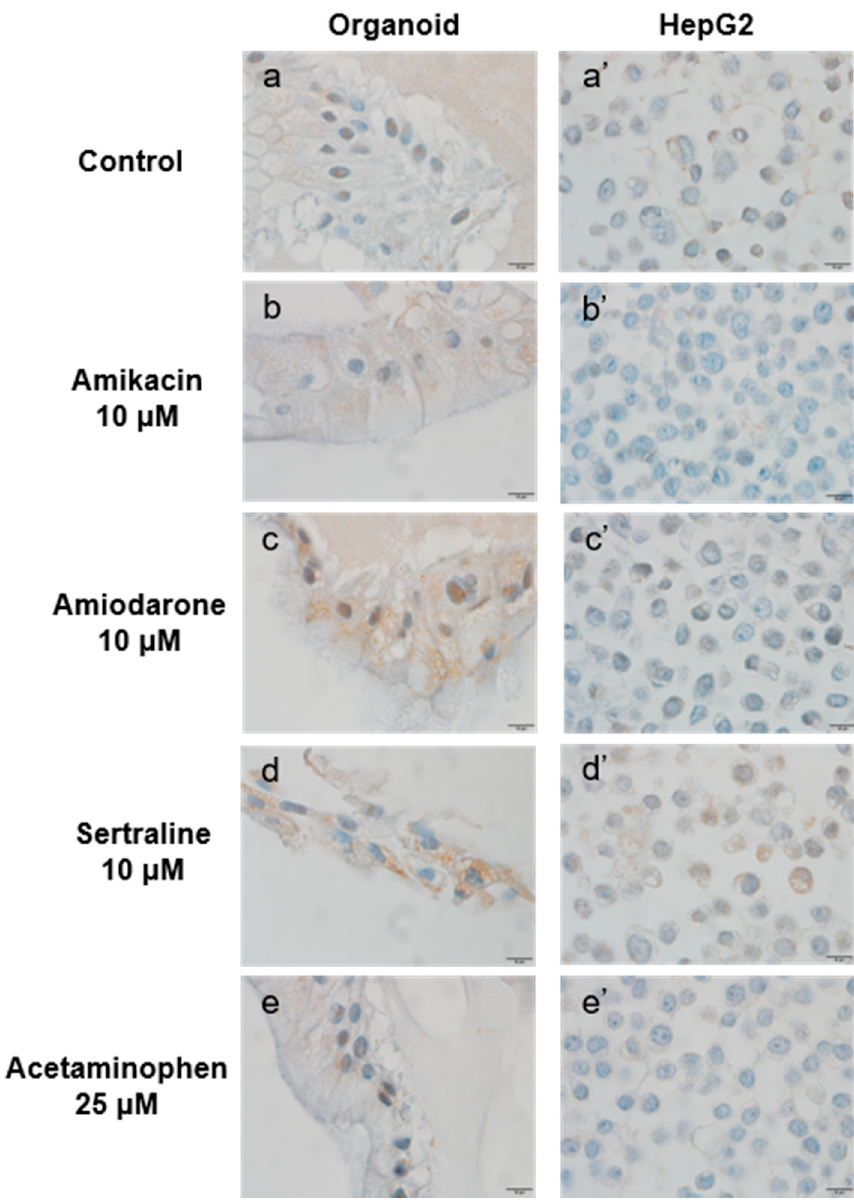
Figure 8. LAMP-2 expression in organoids and HepG2 cells following incubation with the indicated agents. Organoids ( a – e ) and HepG2 cells ( a’ – e’ ) were treated with the indicated PL-inducing drugs or untreated for 48 h as follows: Control (untreated) ( a , a’ ), 10 µ M amikacin ( b , b’ ), 10 µ M amiodarone ( c , c’ ), 10 µ M sertraline ( d , d’ ), and 25 µ M acetaminophen ( e , e’ ). Brown signals indicate positive staining for LAMP-2. Original magnification, × 1000. Bar indicates 10 µ m.